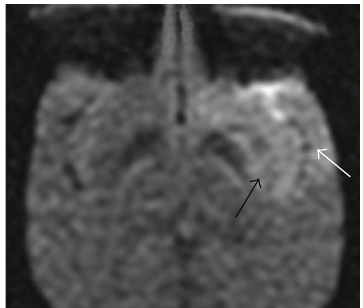
Figure 7: 48h DWI shows high-signal in basal ganglion (black arrow) and signal recovery in temporal lobe with scattered high signal (white arrow).